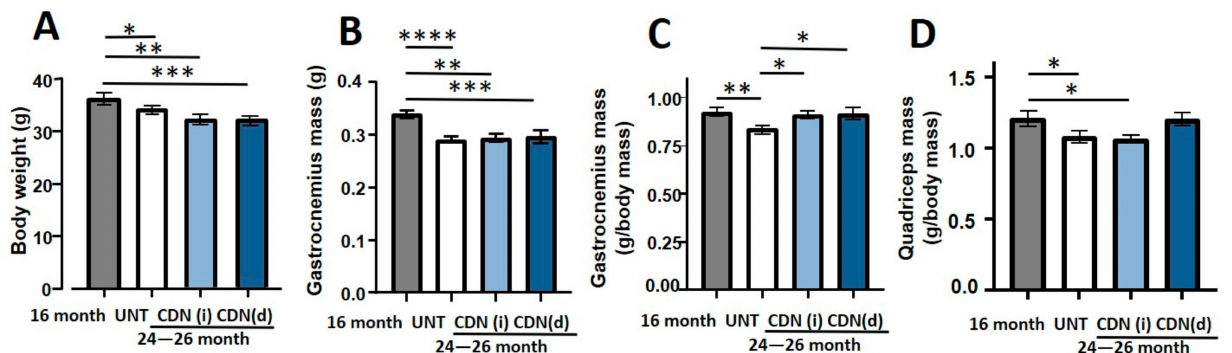
Figure 2. Body weights and muscle masses. CDN1163 treatment did not alter the age-related change in the body weight ( A ) and absolute mass of gastrocnemius muscle ( B ). However, when muscle mass was normalized for body weights, CDN1163 prevented atrophy of gastrocnemius ( C ) and quadriceps muscles ( D ), albeit with the diet only, in the 26 months old, aged mice, when compared to vehicle treated control group. Values are expressed as mean ± SEM; ( n = 8–9 mice/group); one-way analysis of variance. * p ≤ 0.05, ** p ≤ 0.01, *** p ≤ 0.001, **** p ≤